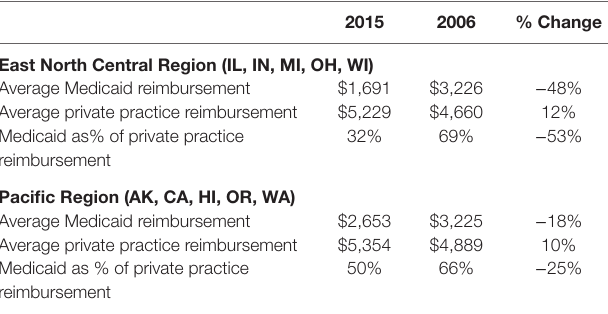
Table 8 | Comparison of reimbursement rates between private practice fees and Medicaid fees for the East North Central Division and the Pacific Division 2006–2015